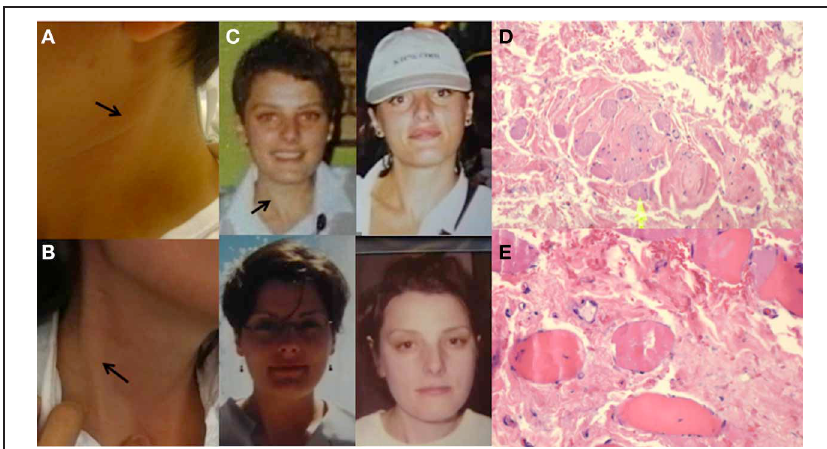
FIGURE 1 | Sternocleidomastoid appearance in Case 1 (A) and Case 2 (B). The taut sternocleidomastoid muscle is also appreciated in older photos taken of Case 2 at the age of 20, 26, 29, and 30 years, clockwise (C) . H&E stained slides of muscle of Case 1 showed dense, fibrotic replacement, with collagen deposition containing scattered fibroblast nuclei and entrapped, atrophic skeletal muscle fibers at low (D) and high magnification (E) . No inflammation was